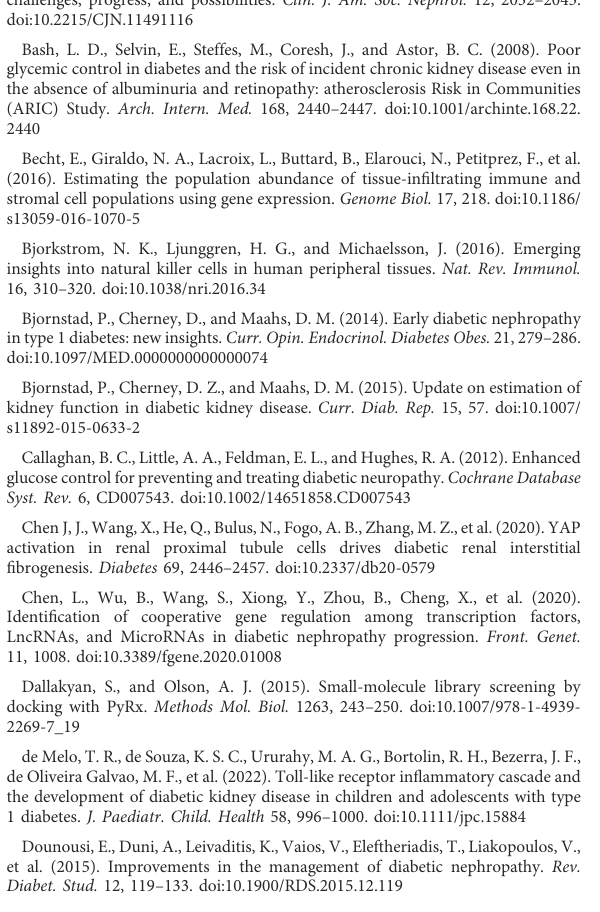
SUPPLEMENTARY FIGURE S3 The determination of soft-thresholding power. (A) Histogram of connectivity distribution when beta=16. (B) Checking the scale free topology when beta = 16. SUPPLEMENTARY FIGURE S4 The expression patterns of hub genes among normal control and DKD samples in GSE30122. SUPPLEMENTARY FIGURE S5 The expression patterns of hub genes among normal control and DKD samples in GSE96804. SUPPLEMENTARY FIGURE S6 The expression patterns of hub genes among normal control and DKD samples in GSE104954. SUPPLEMENTARY TABLE S1 GO enrichment analysis of the commonly shared DEGs. SUPPLEMENTARY TABLE S2 KEGG enrichment analysis of the commonly shared